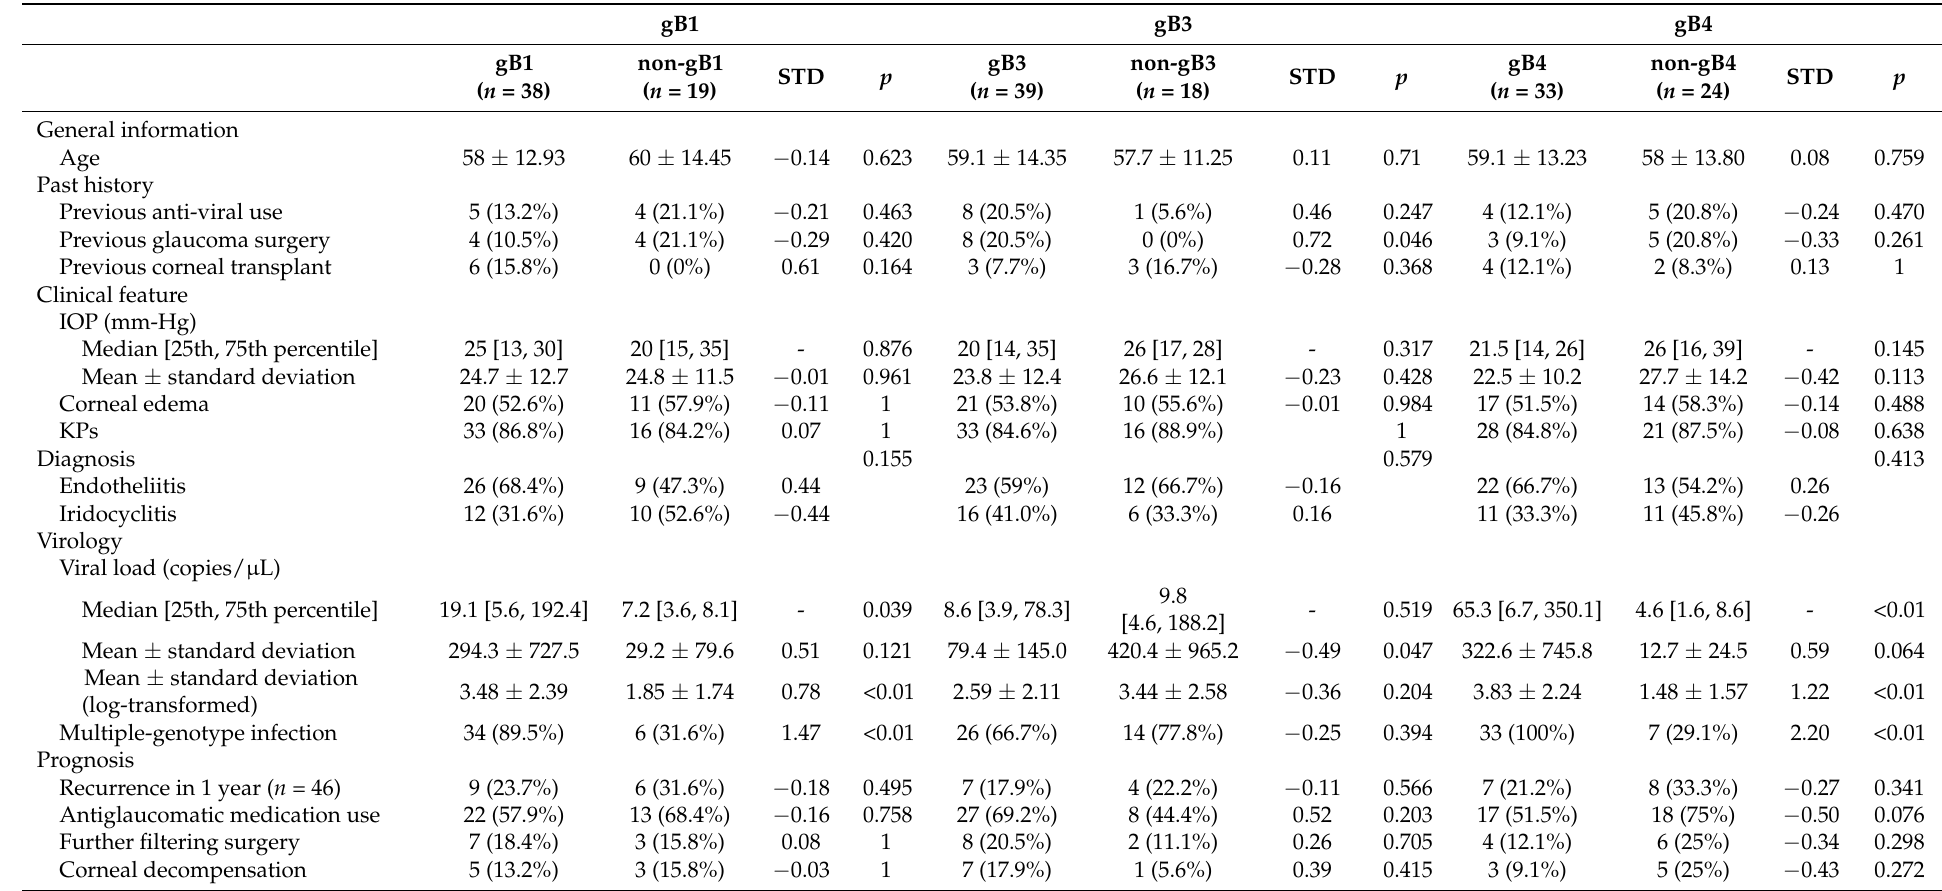
Table 3. Comparison of clinical characteristics and prognosis between the patients with cytomegalovirus anterior segment infection with different glycoprotein